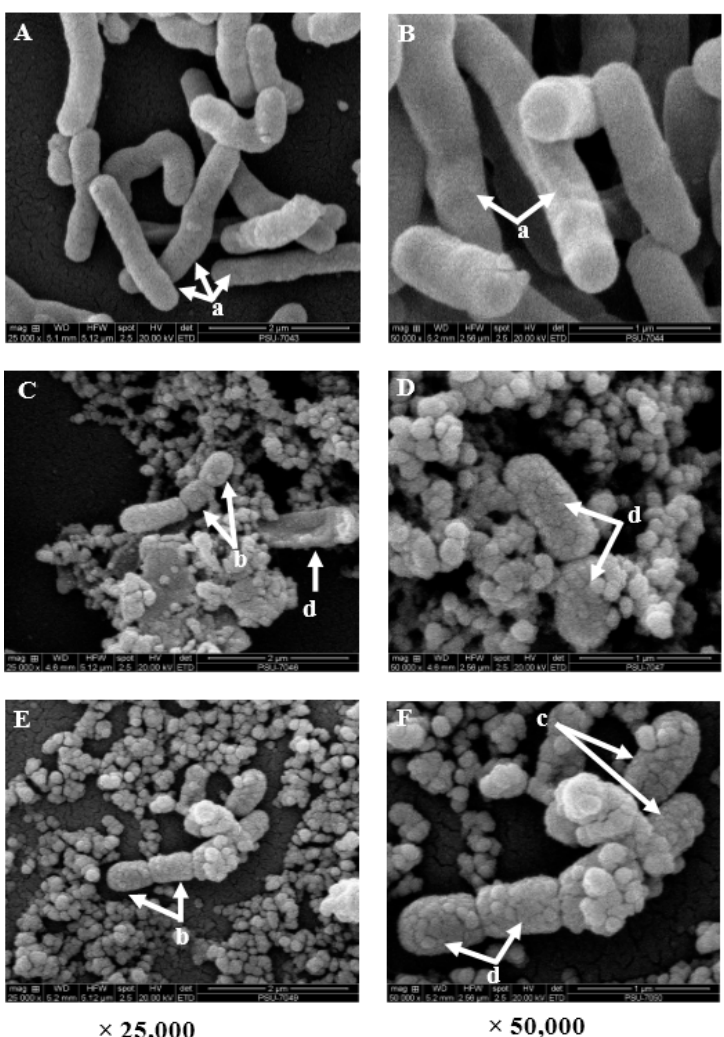
Figure 4. Scanning electron micrographs of Listeria monocytogenes Scott A cells exposed